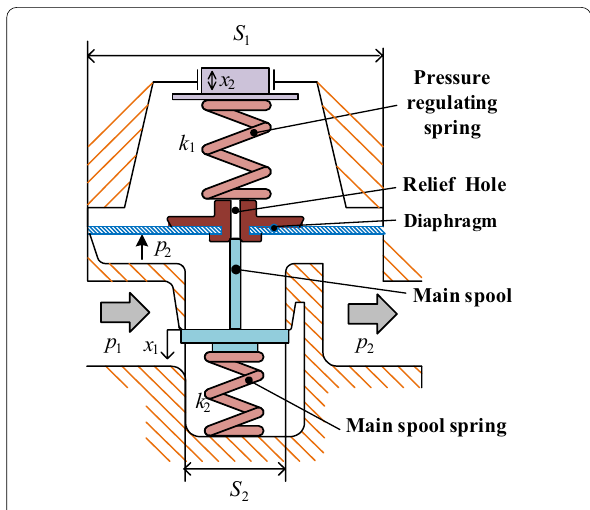
Figure 5 Structure of the diaphragm pressure